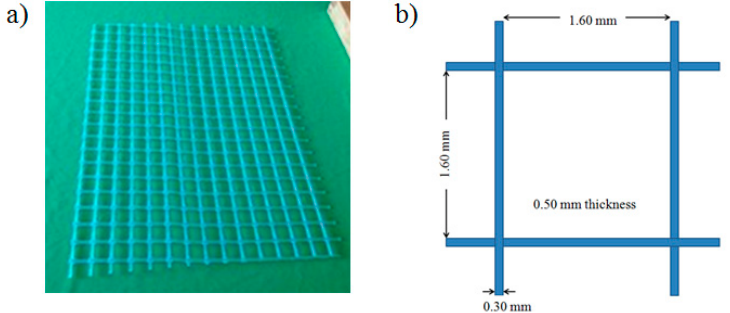
Figure 2. ( a ) Image of the imprinted spacer and ( b ) its dimensions.